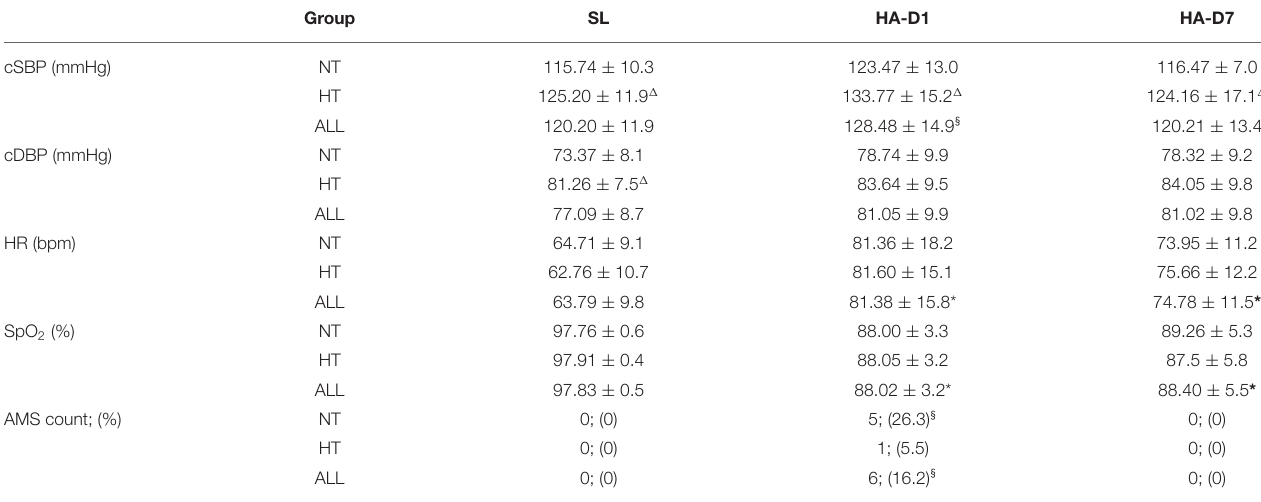
TABLE 2 | Clinic systolic blood pressure (cSBP), clinic diastolic blood pressure (cDBP), HR, SpO 2 at SL, and AMS prevalence on the first and seventh days at HA in all participants and grouped by NT and HT